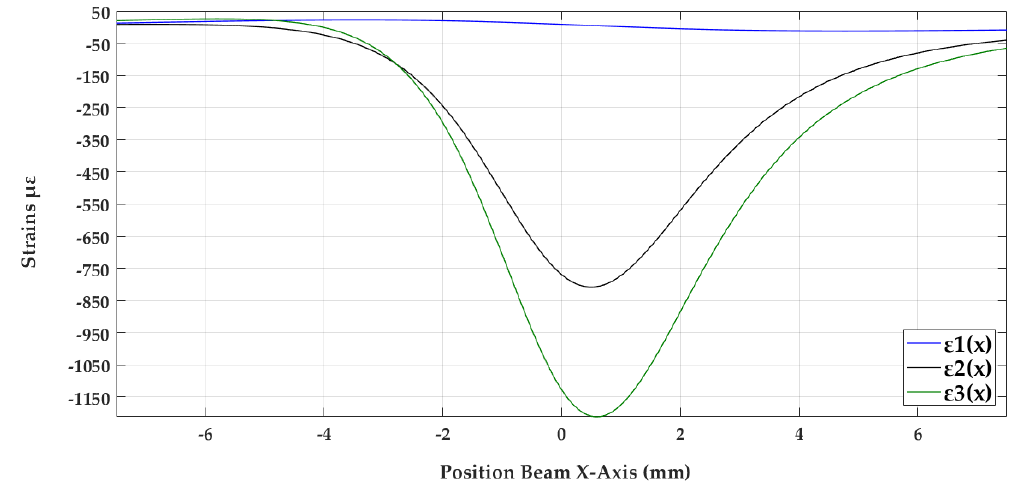
Figure 8. Behavior strain of the elastic bodies with geometries 6a, 6d and 6d optimized.